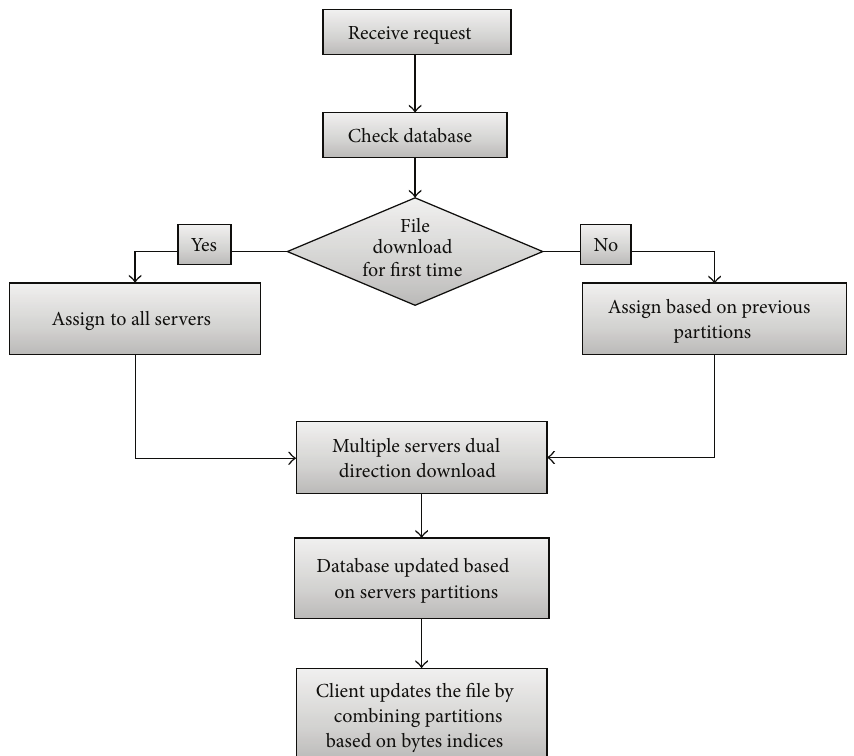
Figure 5: Downloading file from cloud